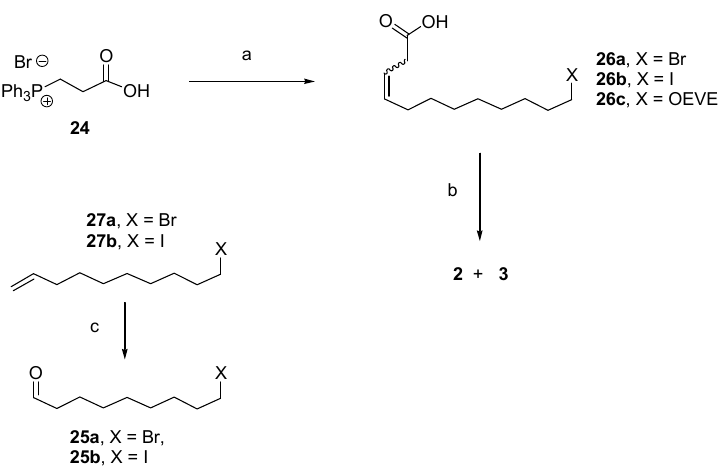
Scheme 3. Synthesis of a mixture of 2:1 Z - : E- lactone ( 2 : 3 ).